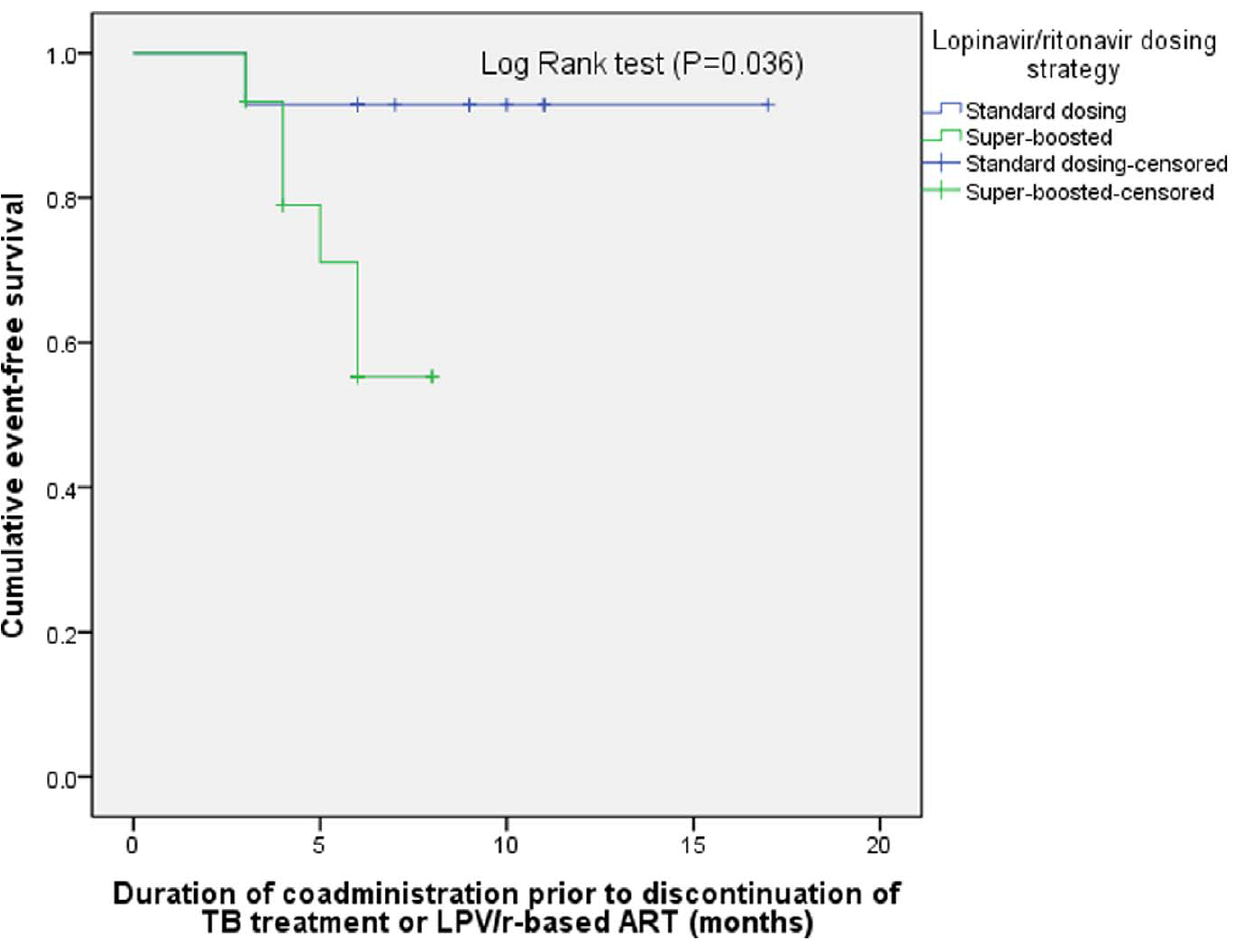
Figure 2. Kaplan-Meier survival curve for the impact of lopinavir/ritonavir dosing strategy among patients with HIV/TB coinfection on time until treatment discontinuation.